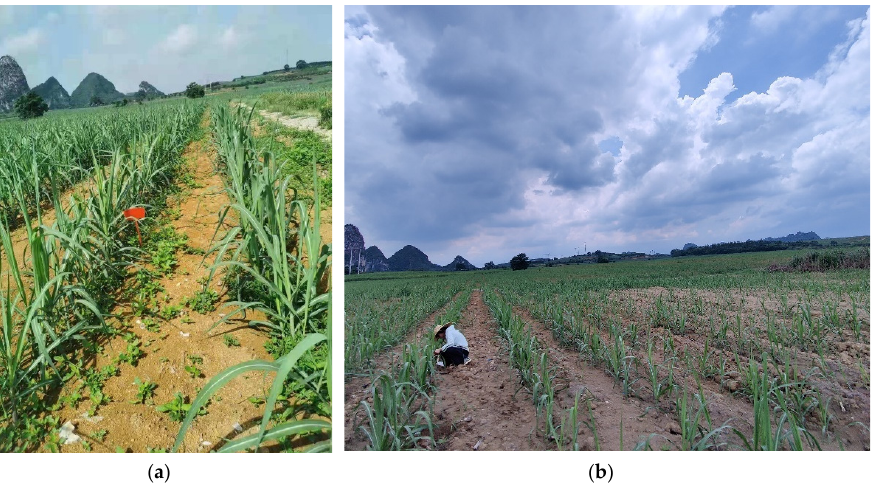
Figure 13. ( a ) Cane seed planted by this device. ( b ) Cane seed planted by other existing devices.